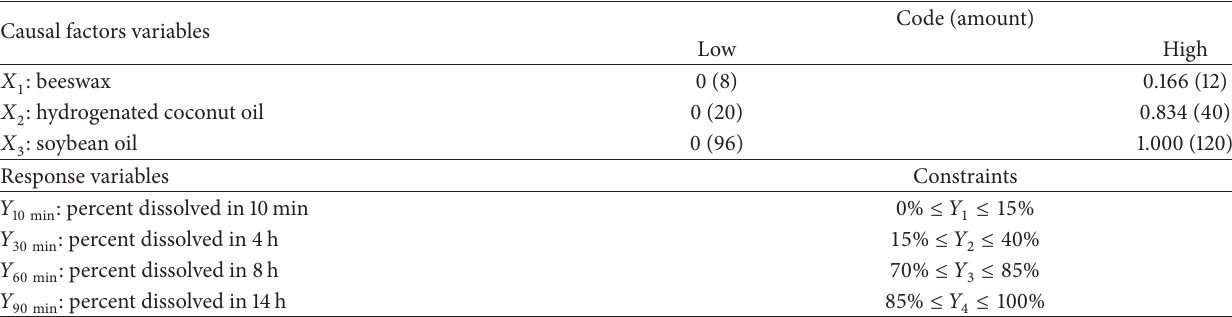
Table 1: Summary of variables for the mixture design.